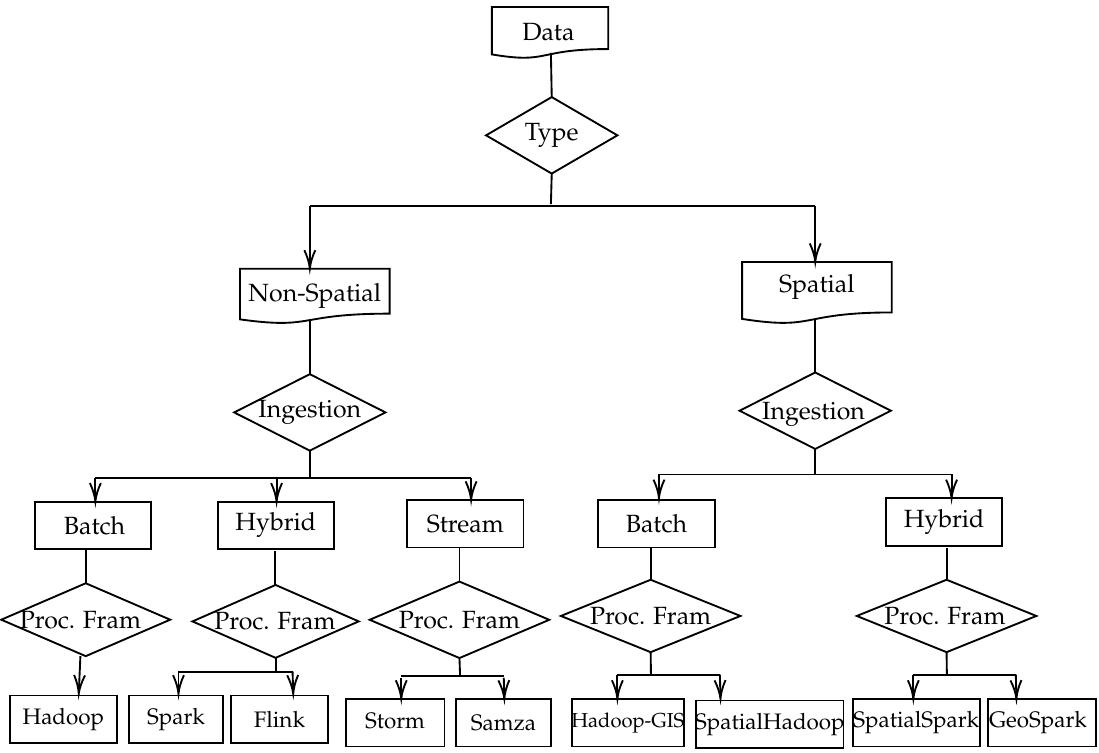
Figure 3. Big data processing framework selection